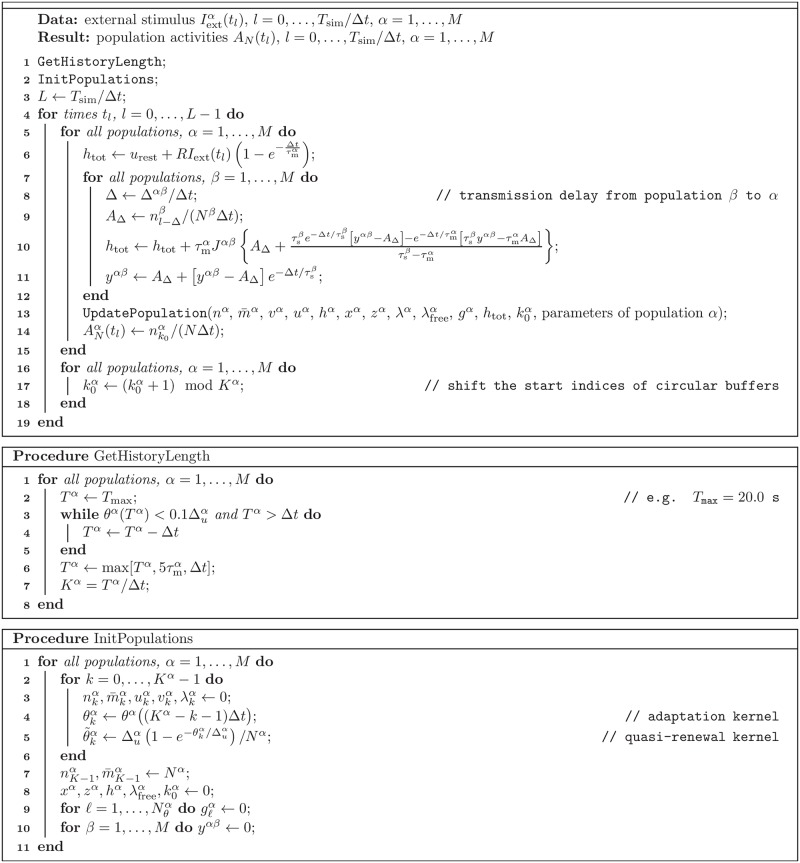
Pseudocode for the integration of the mesoscopic population equation.Note that procedure UpdatePopulation in line 12 is shown in Fig 12.